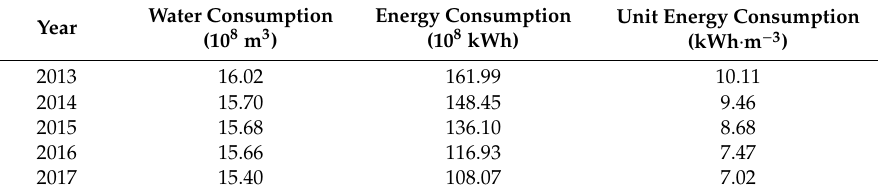
Table 1. Water and energy consumed over the entire life cycle of water resources.